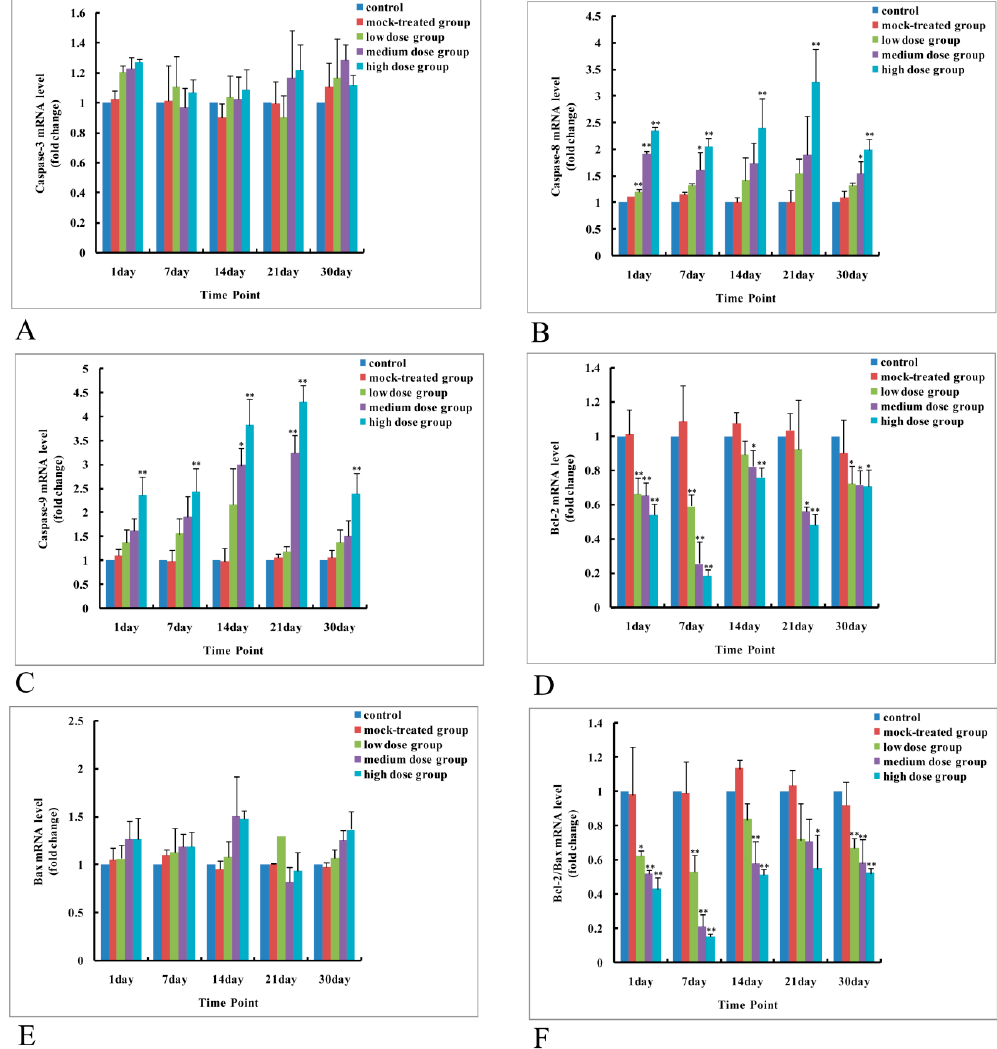
Figure 4. mRNA level changes of apoptosis-related genes in cerebral cortex of mice offspring after maternal exposure to PM 2.5 during pregnancy. ( A ) Caspase-3; ( B ) Caspase-8; ( C ) Caspase-9; ( D ) Bcl-2; ( E ) Bax; ( F ) ratio of Bcl-2 to Bax. * p < 0.05, compared with control; ** p < 0.01, compared with control.